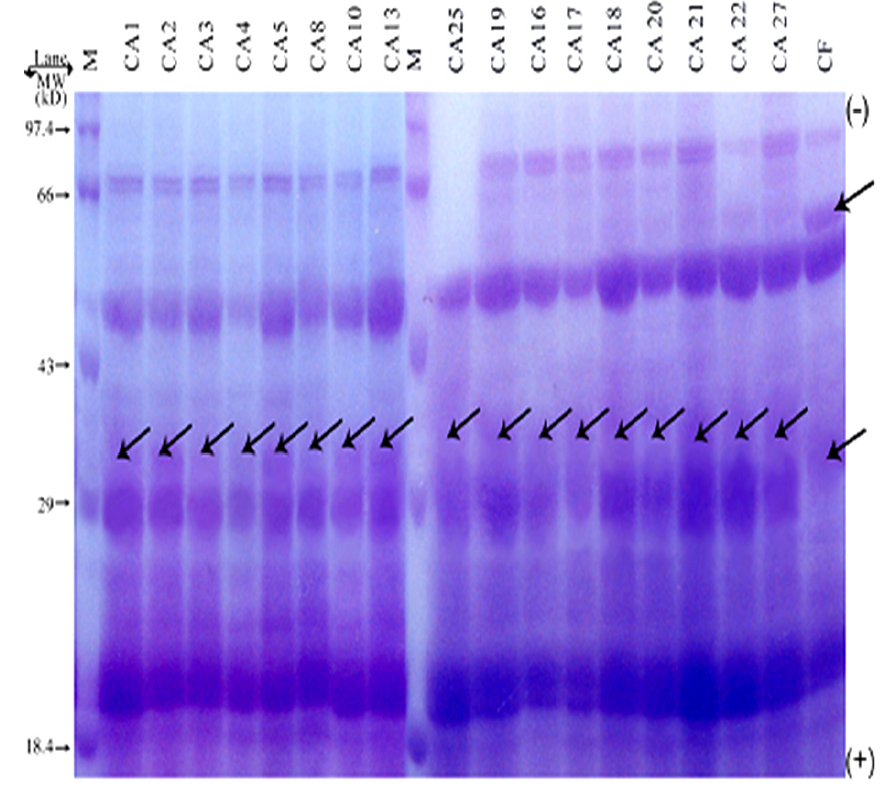
Fig. 1. Seed storage protein profiles in eighteen genotypes of chili pepper ( Capsicum L.) on 10% SDS polyacrylamide gel. Arrows represent the species specific